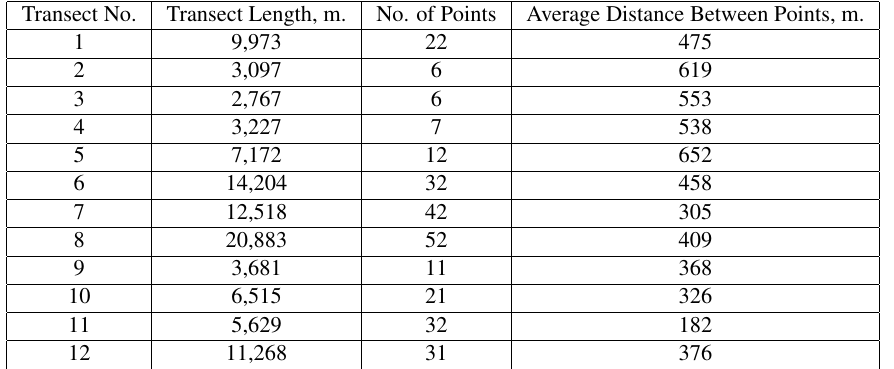
Table 1: Ground control points used in the DEM vertical accuracy assessments, grouped by transect. Refer to Figure 1 for their locations.